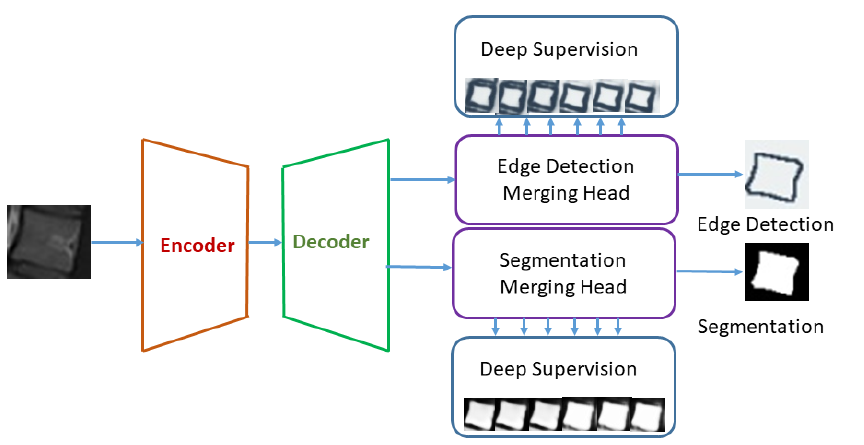
Figure 7. High-level structure of HED U-Net. Encoder and decoder compute the feature maps pyramids and specific task-merging heads unite this information using hierarchy attention maps [43].